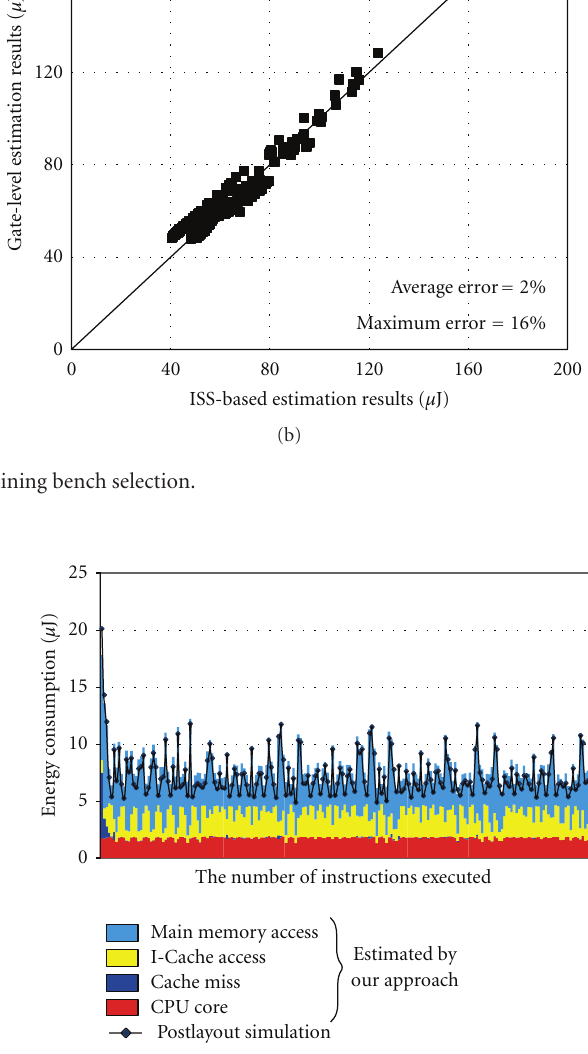
Figure 6: Results for MPEG2 encoder run on